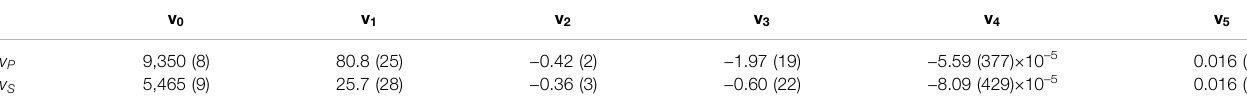
TABLE 1 | Fitting coef fi cients and their uncertainties of Eq. 10 to calculate the P- and S- wave velocities of β -(Mg 0.87 Fe 0.13 ) 2 SiO 4 at HT-HPs. v